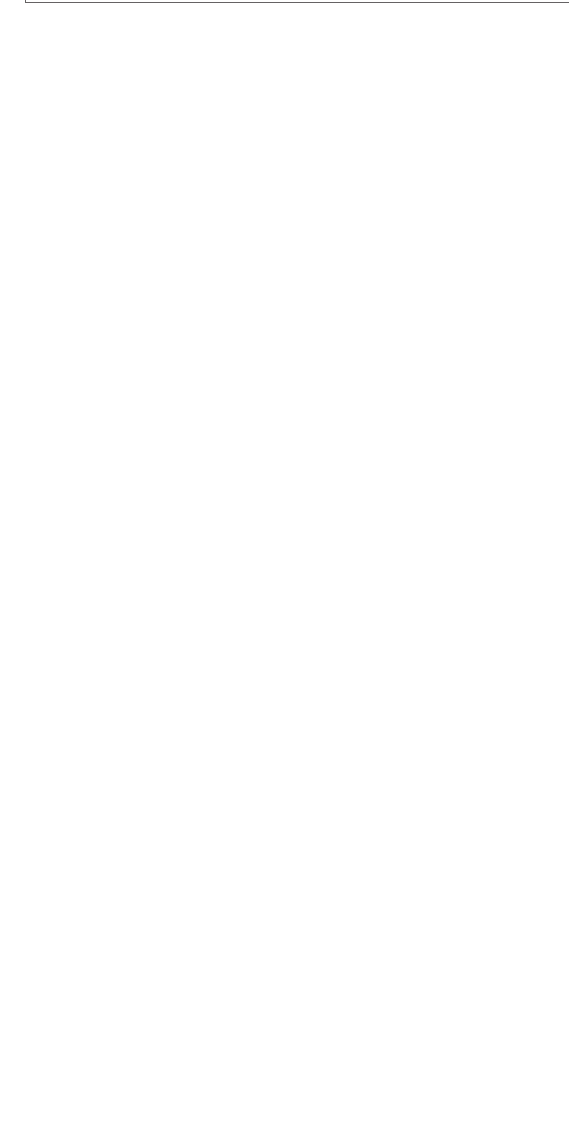
FigUre a1 | Patient with exophytic vulva tumor treated with 10 mA for 60 min. Bubbling around the cathode (2) and irreversible tissue damage between the electrodes (3). Courtesy of Dr. Luis Bergues Cabrales (unpublished